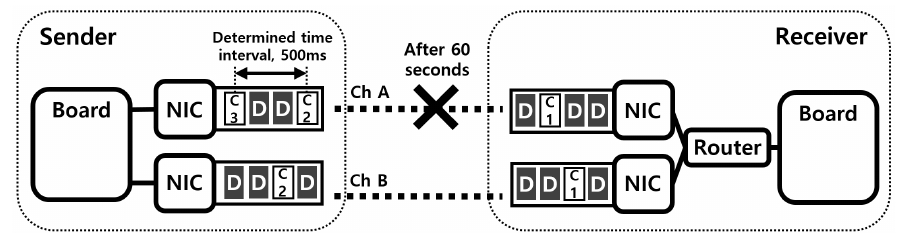
Figure 13. The experiment setup for evaluating the performance of